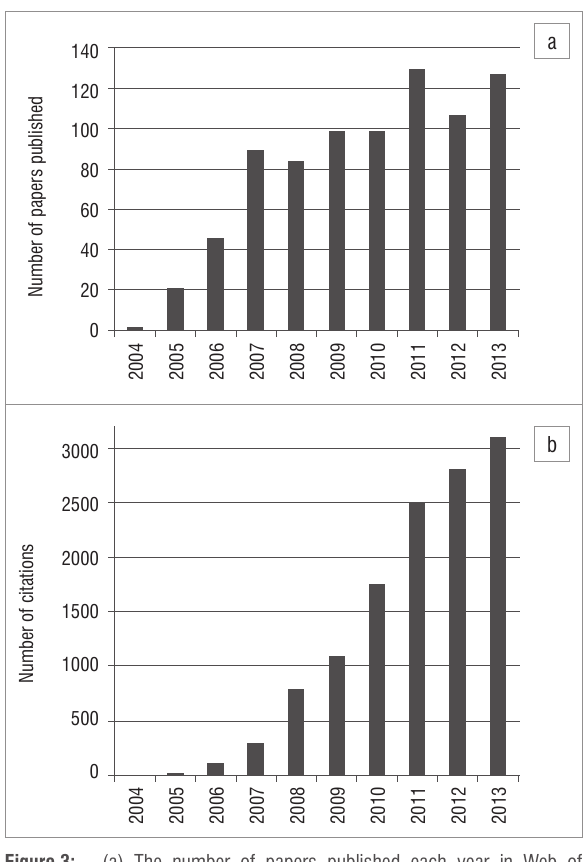
(a) The number of papers published each year in Web of Science (formerly ISI) indexed journals during the first decade of research by the Centre for Invasion Biology and (b) the annual number of citations to papers published by the Centre for Invasion Biology.